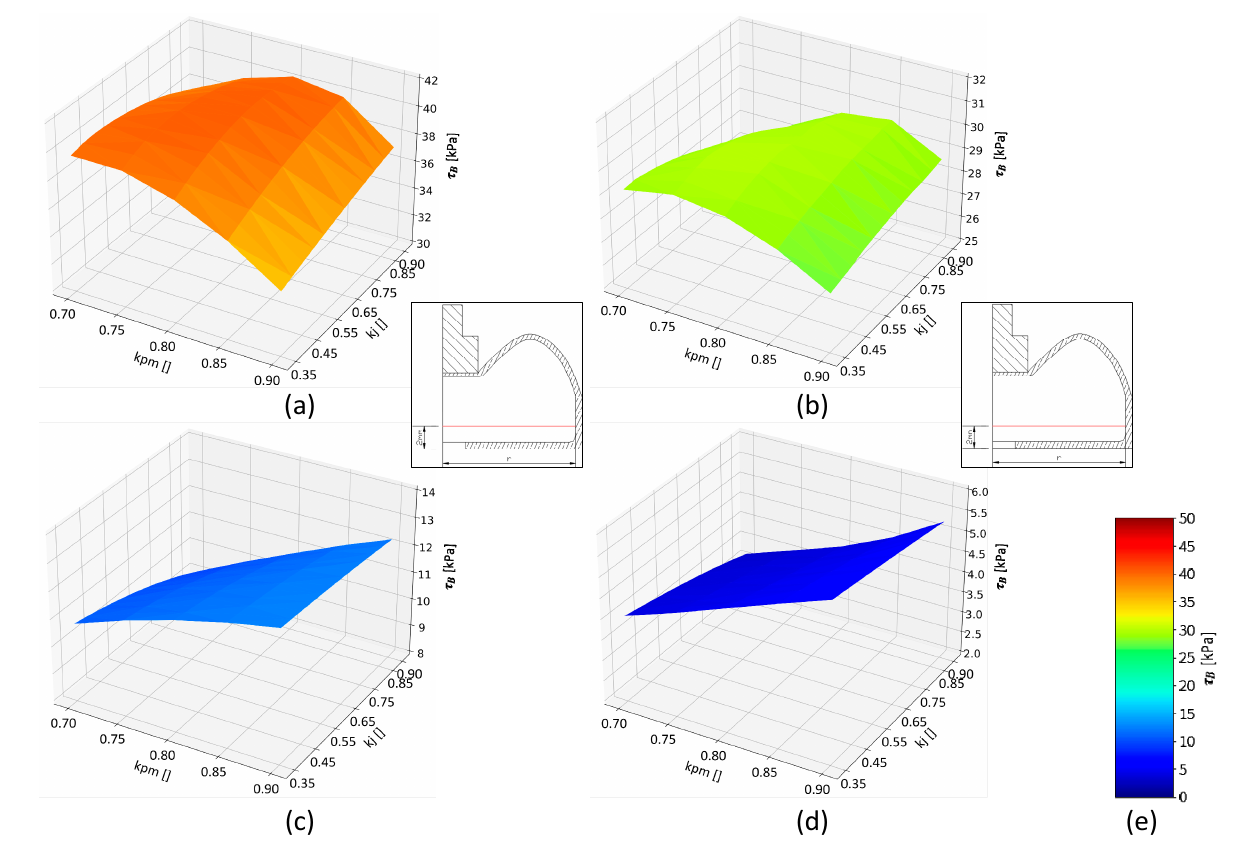
Figure 14. Average values of shear stress τ B along the measurement section of the MR cushion cross section ( Instance 2 ) for all configurations kpm / kj . Analysis was performed for the value gm = 6 mm and the magnetic field exciter distance z equal to: ( a ) 0; ( b ); ( c ) 5; ( d ) 10 mm; ( e ) color scale indicating shear stress value.